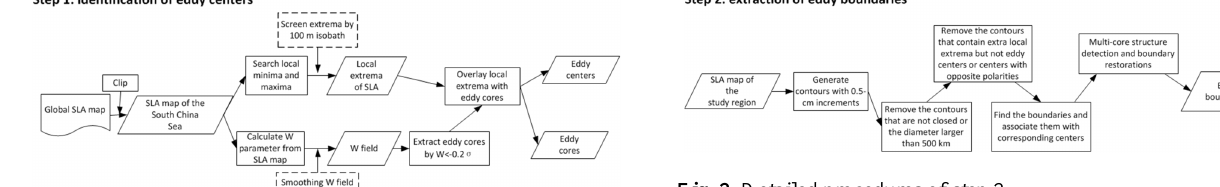
Fig. 2. Detailed procedures of step Figure 2. Detailed procedures of step 2. 2